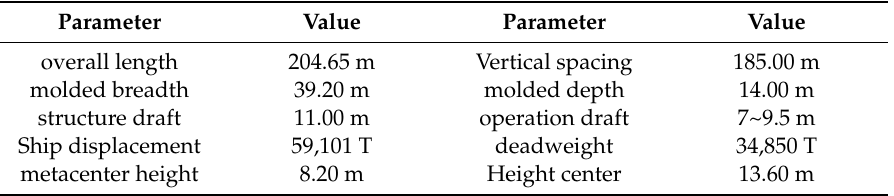
Table 2. Vessel parameters.